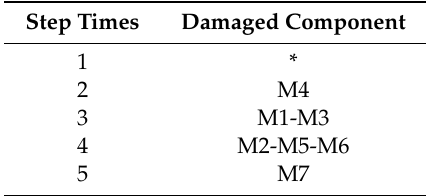
Table 4. The optimal priority list of the damaged components in the 34 bus case.